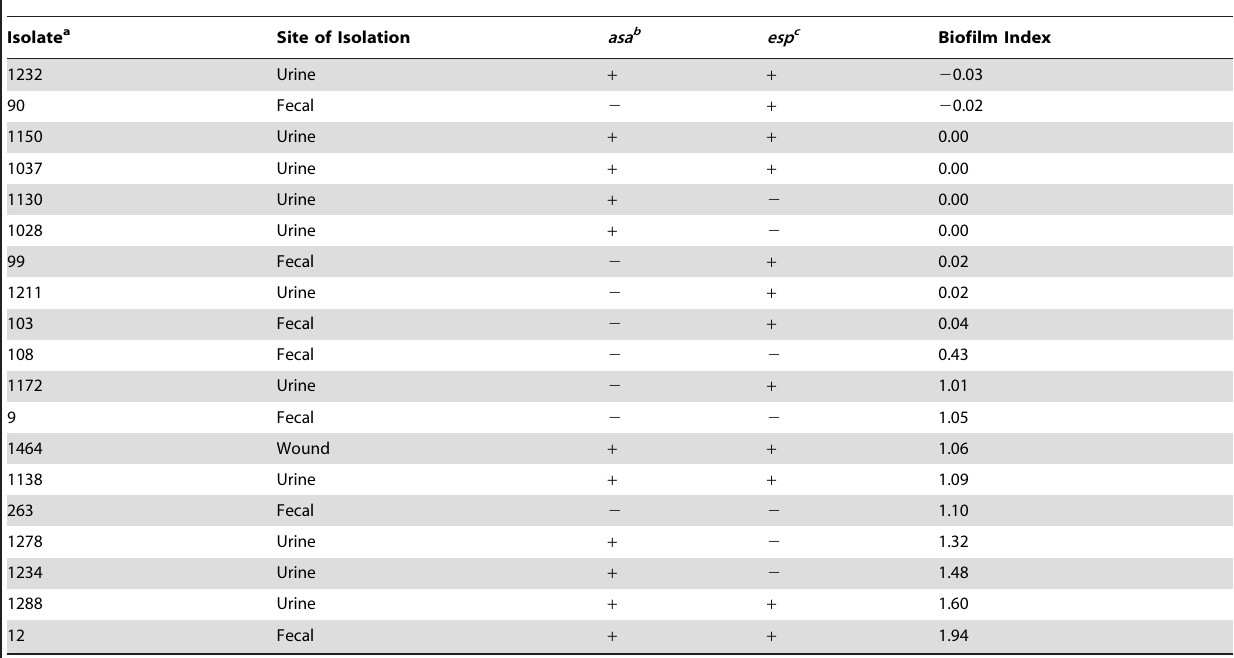
Table 1. Characteristics of clinical Enterococcus faecalis study isolates.